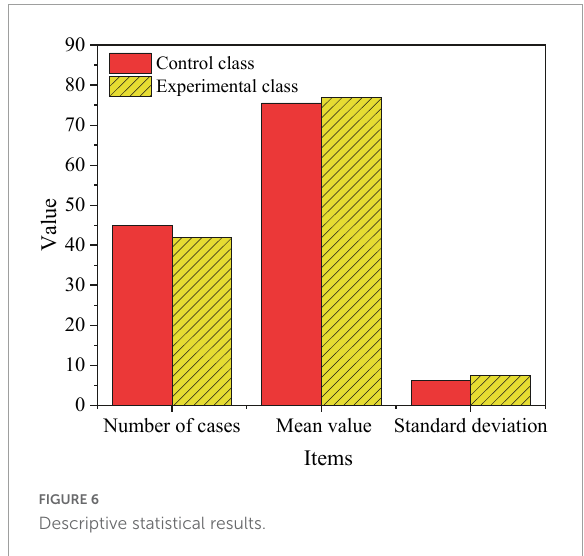
FIGURE6 Descriptive statistical